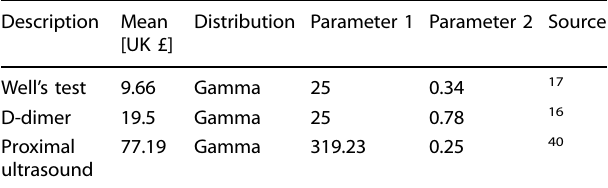
Table 16. Costs of the diagnostic